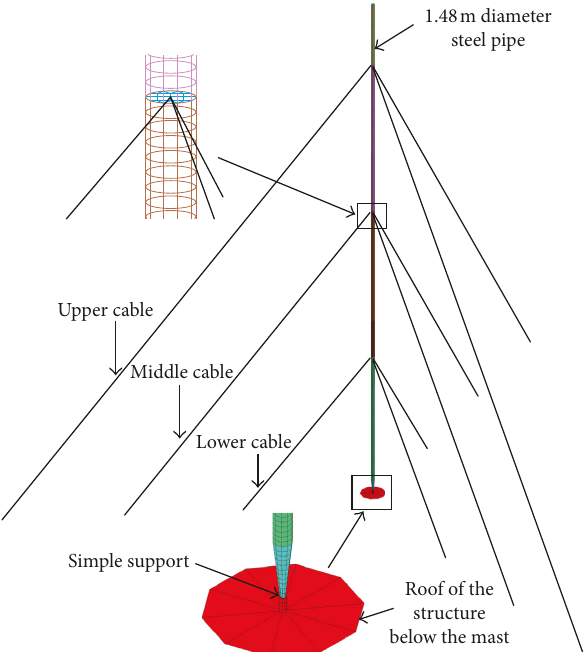
Figure 3: Overview of the FEM model in LS-DYNA.